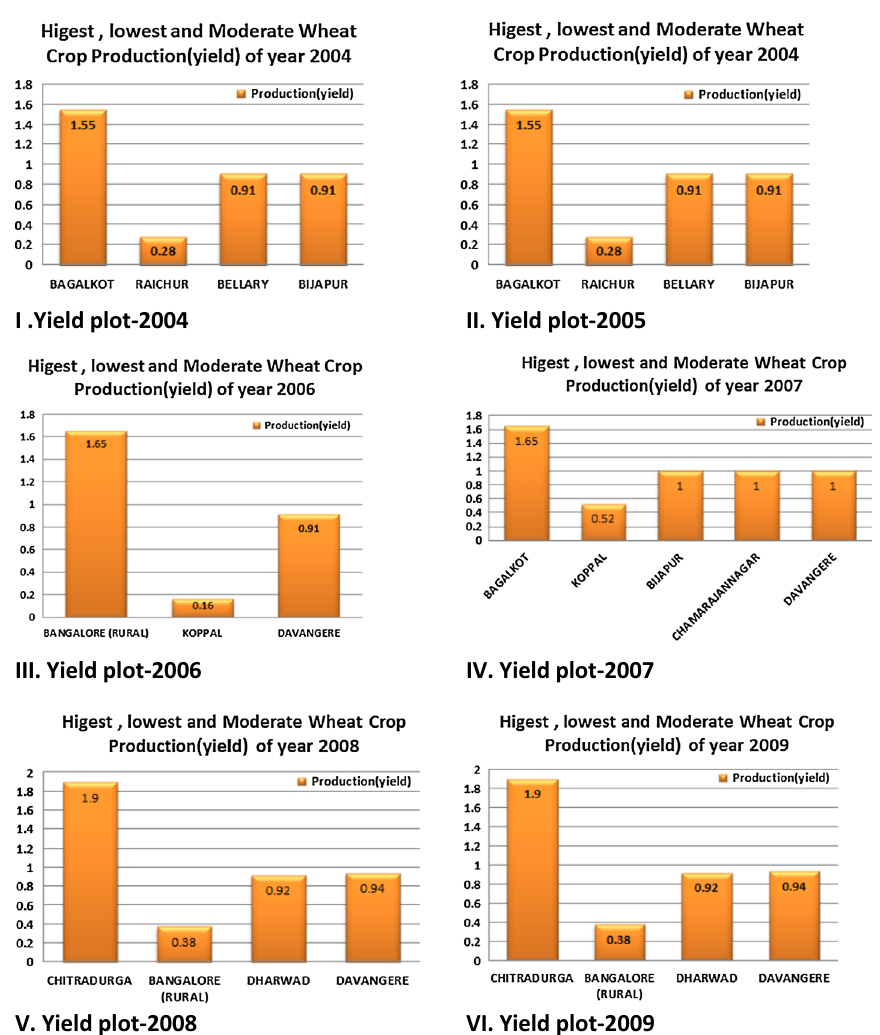
Results for optimal temperature and rainfall for wheat—Table 5